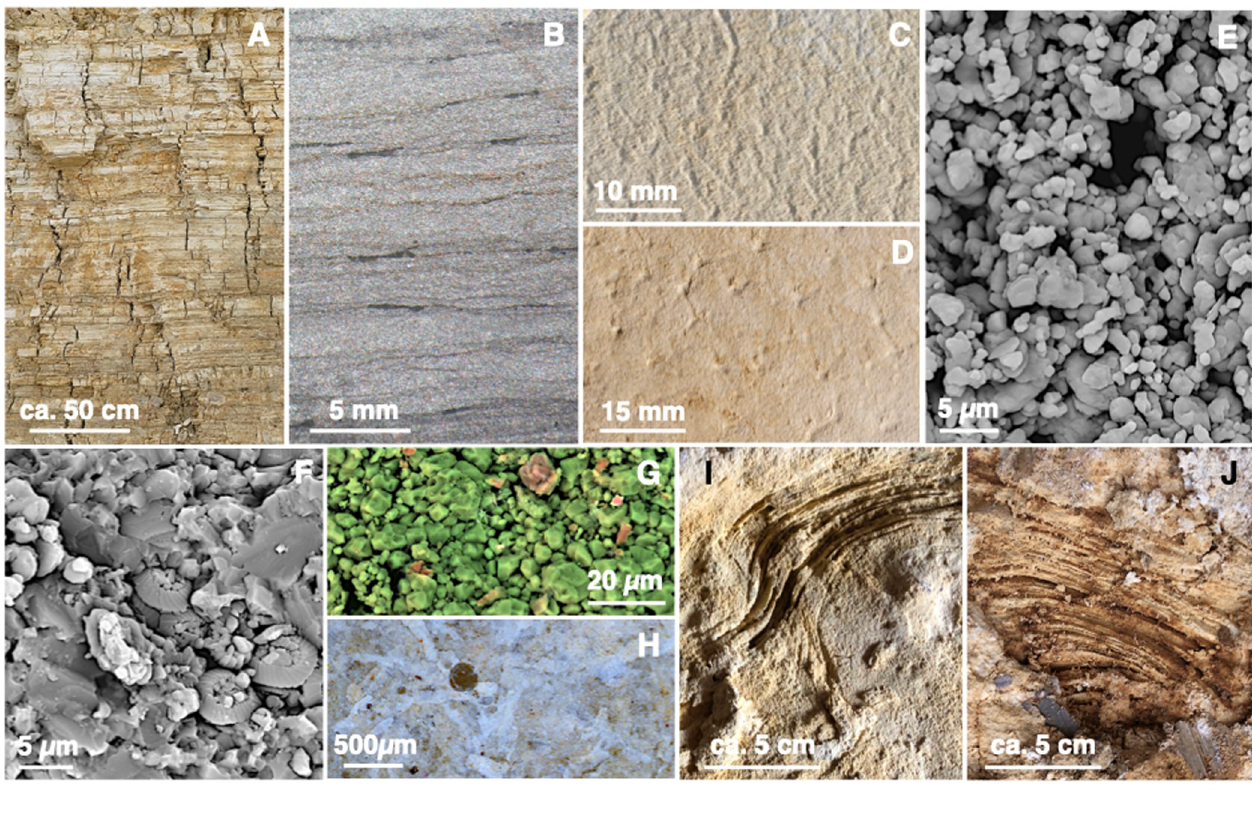
Fig 4. Images of plattenkalk sediments of the Solnhofen archipelago. (A)—plattenkalks of the Ettling quarry. (B)—photomicrograph of a polished thin slab of a dense plattenkalk layer in cross section from the Blumenberg quarry near Eichsta¨tt, with thin opaque layers rich in (?) organic material. (C) and (D)— surfaces of plattenkalk layers with impressions from former bacterial mats. (E)—backscattered electron SEM image of plattenkalk in cross section from the Ettling quarry to illustrate the high porosity of some plattenkalks and the grain size distribution of calcite particles. (F)—a plattenkalk horizon from a road exposure near the Blumenberg quarry in Eichsta¨tt, with coccolites concentrated on layer surfaces. (G)—energy-dispersive electron image of a micritic limestone from the Ettling quarry; calcite in green, siliclastic material in red. (H)—photomicrograph of a plattenkalk layer surface near Eichsta¨tt, with whitish calcite pseudomorphs. (I) and (J)—(bio)-laminar structures from the Mu¨lheim quarry interpreted as stromatolites (photo courtesy Roland Po¨schl 2019).